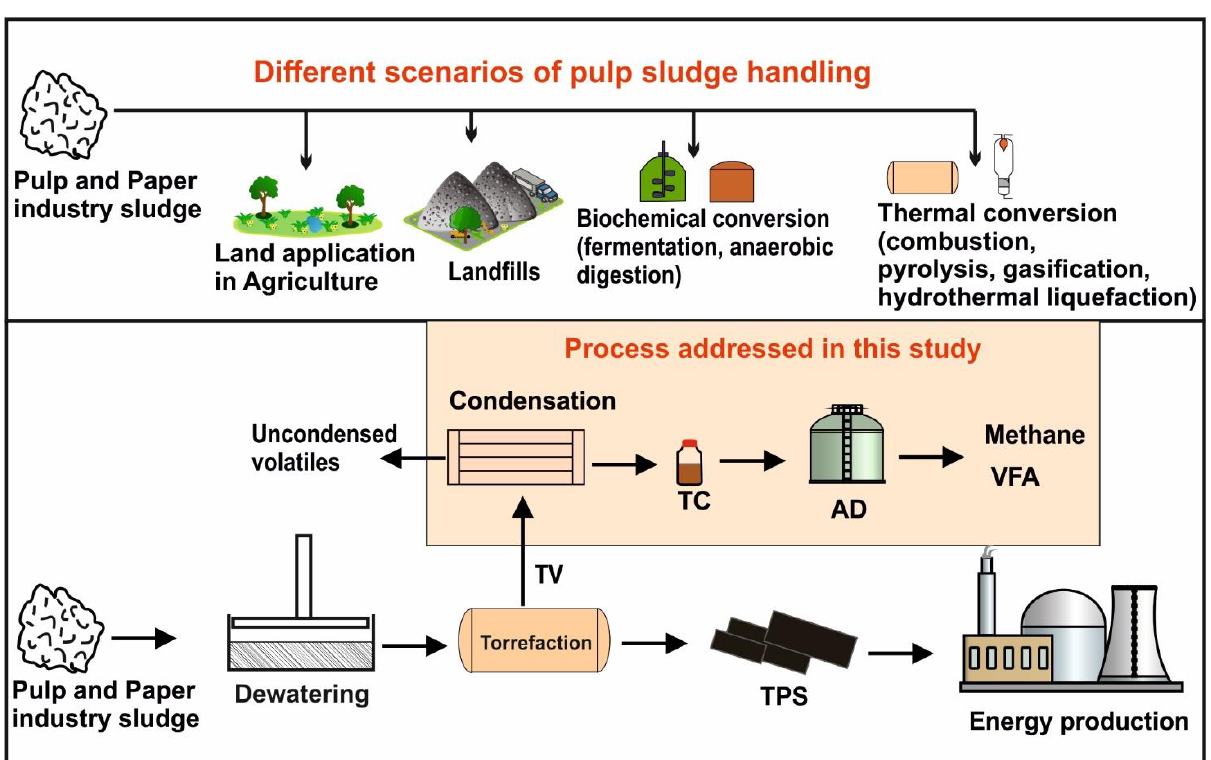
Figure 1. Innovative process integration approach to produce bioenergy and biochemicals from pulp industry sludge.